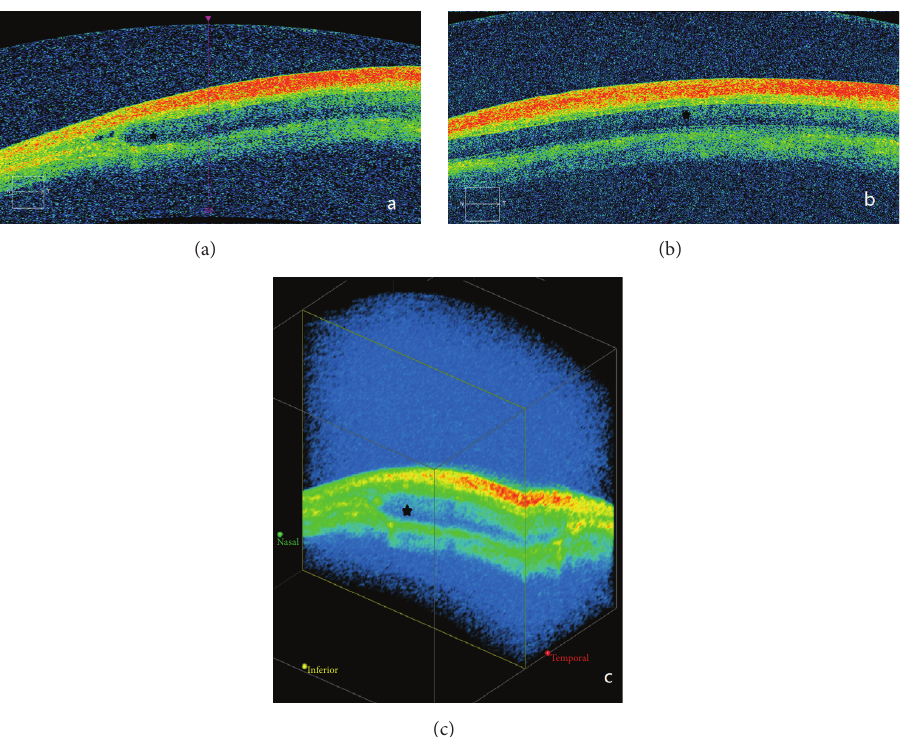
Figure 8: Imaging of OCT examination. (a) Horizontal section of the subconjunctival fluid space. (b) Three-dimensional reconstruction of the subconjunctival fluid space. (c) Vertical section of the subconjunctival fluid